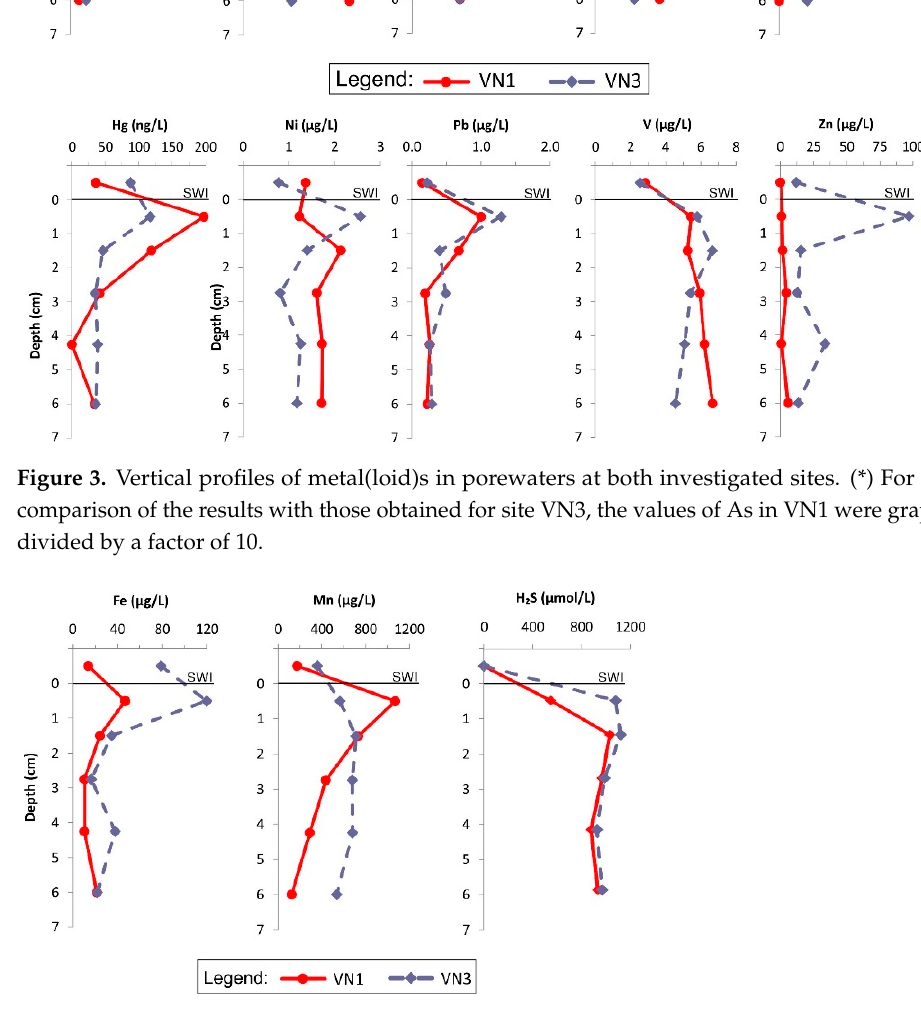
Figure 4. Comparison between vertical profiles of dissolved Fe, Mn and H 2 S [12] in porewaters in the two selected sites, VN1 and VN3.